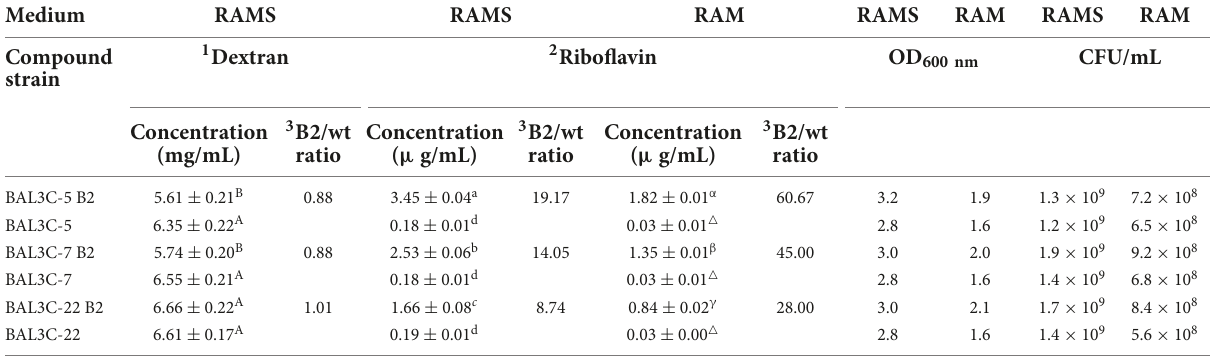
TABLE 2 Comparative analysis of riboflavin and dextran production by the wild-type and mutant W. cibaria strains in RAMS and RAM media. Medium